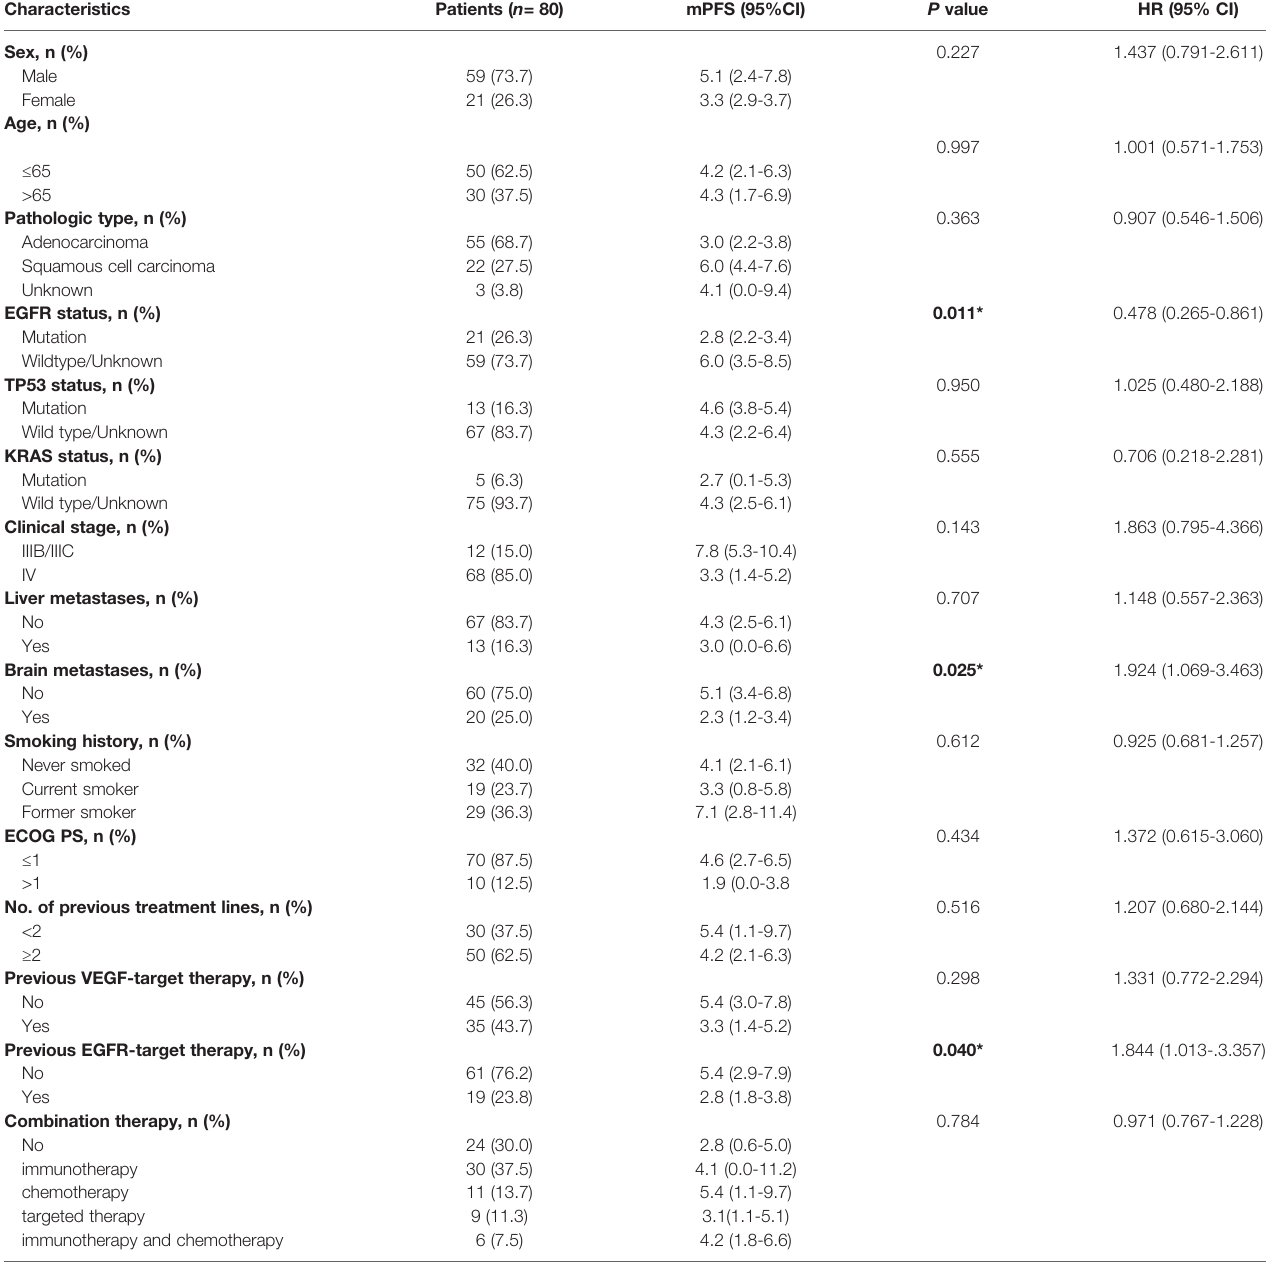
TABLE 1 | Characteristics of patients and univariate analysis of factors associated with progression – free survival in the entire sample.